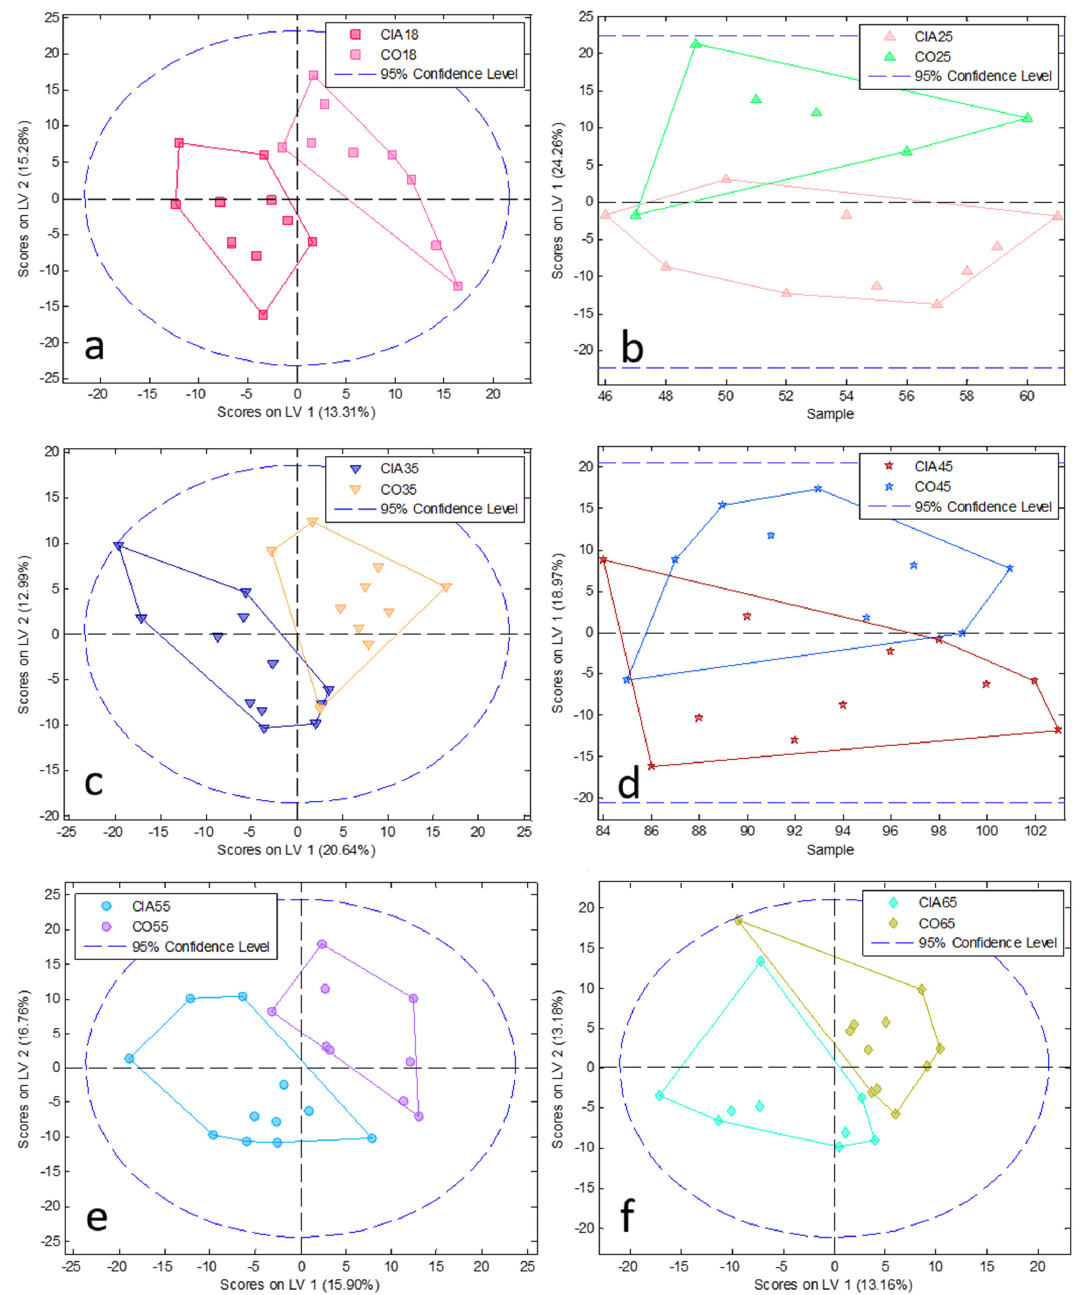
Figure 3. PLSDA analysis at each time point between CIA and CO (pair analysis). Graphics from ( a – f ) show comparison among 18, 25, 35, 45, 55, and 65 days, respectively. CIA18: CIA group 18 days after disease induction (pink square); CIA25: CIA group 25 days after disease induction (light pink triangle); CIA35: CIA group 35 days after disease induction (dark blue inverted triangle); CIA45: CIA group 45 days after disease induction (red star); CIA55: CIA group 55 days after disease induction (light blue circle); CIA65: CIA group 65 days after disease induction (light blue diamond); CO18: CO group 18 days after the beginning of the experiment (light pink square); CO25: CO group 25 days after the beginning of the experiment (green triangle); CO35: CO group 35 days after the beginning of the experiment (orange inverted triangle); CO45: CO group 45 days after the beginning of the experiment (blue star); CO55: CO group 55 days after the beginning of the experiment (purple circle); CO65: CO group 65 days after the beginning of the experiment (yellow diamond). LV: latent